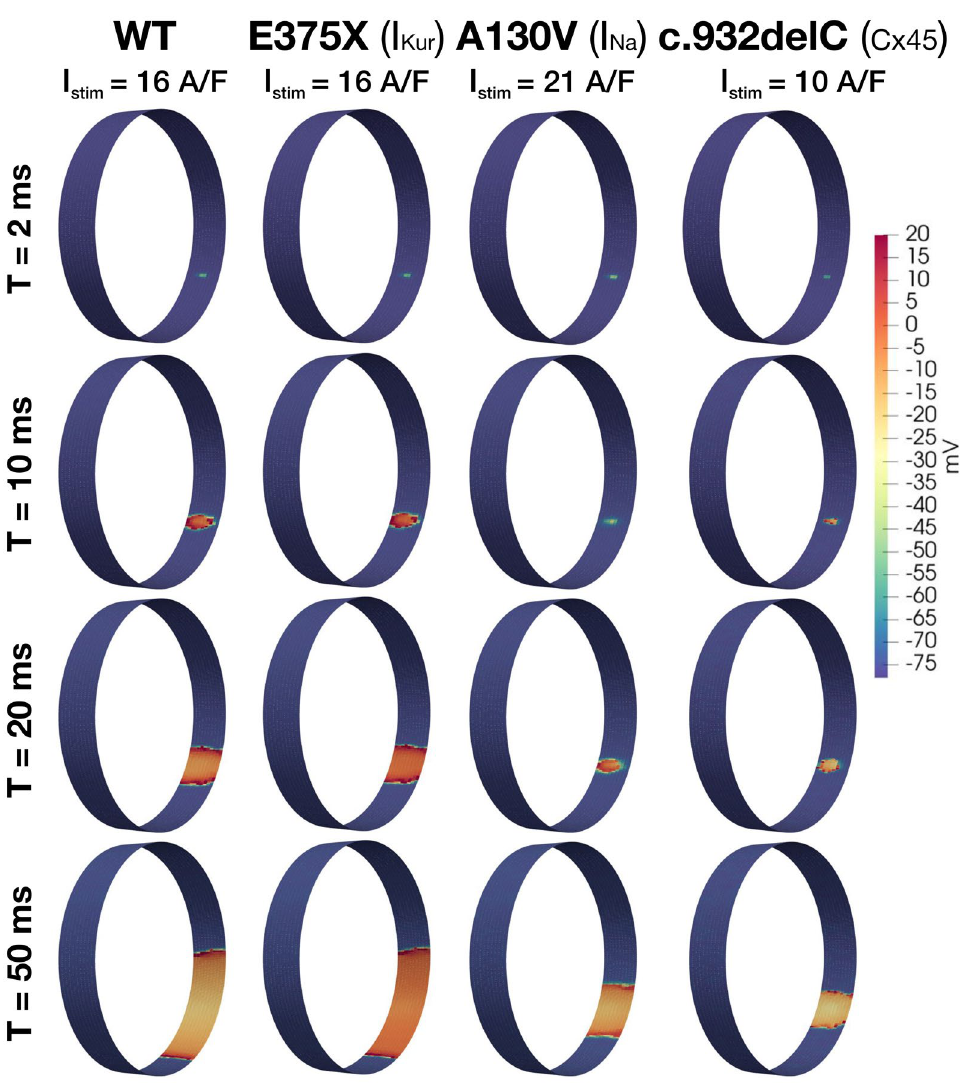
Figure 7. Excitability analysis for WT, and for the E375X, A130V, and c.932delC mutations. This presentation format is the same as that of Fig.